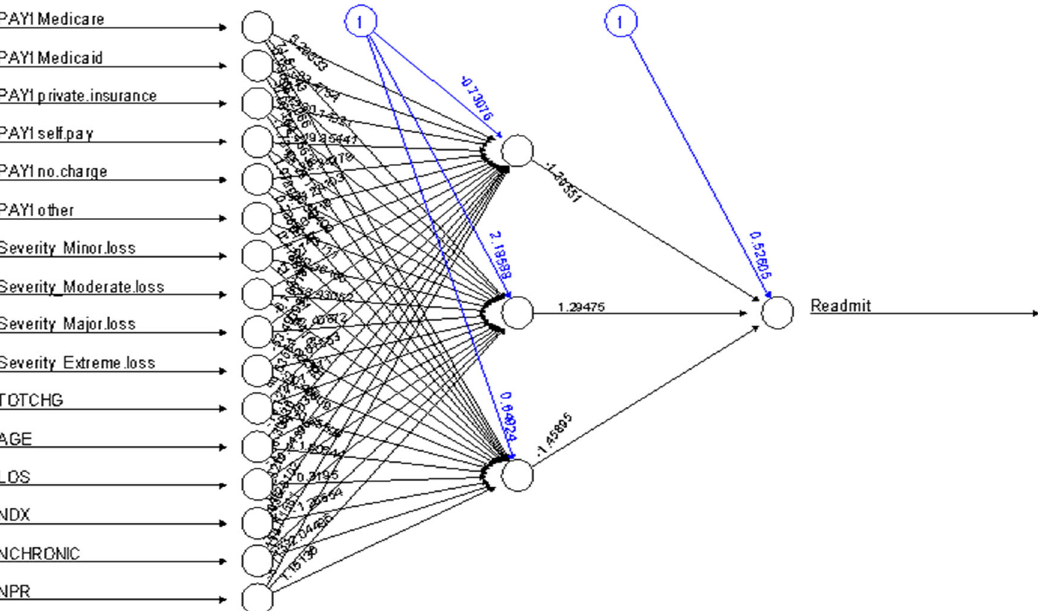
Fig. 5 ANN for 90-day readmission data sets. ANN structure: 16-3-1. The optimal weights of input variables and intercepts are shown as black and blue numbers above the lines separately. BDJ Open (2021)